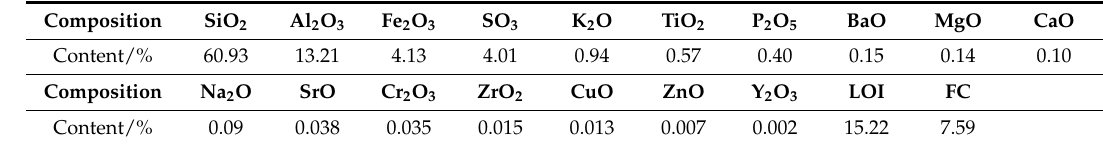
Table 1. Chemical compositions of the raw ore (wt %).